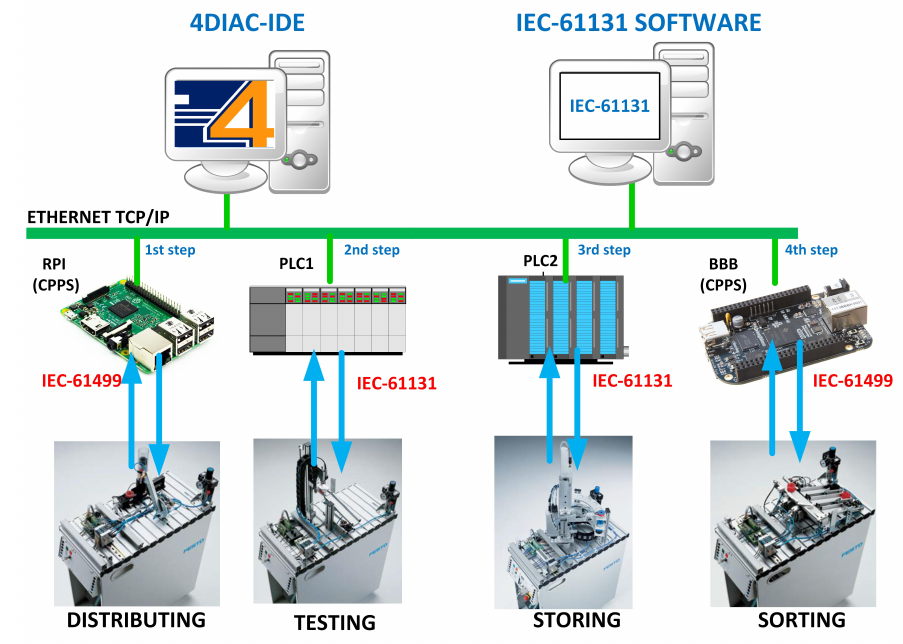
Figure 2. Control scheme of the case study. BBB: BeagleBone Black card; CPPS: cyber-physical production system; PLC: programmable logic controller; RPI: Raspberry Pi